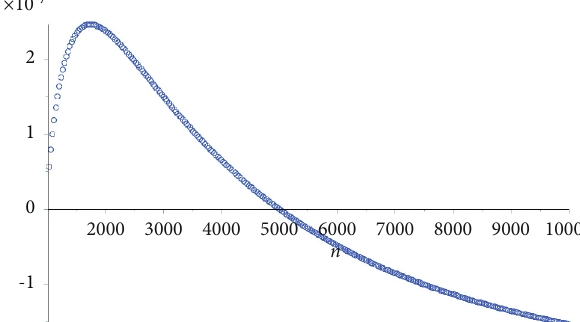
Figure 24: The relative error of F